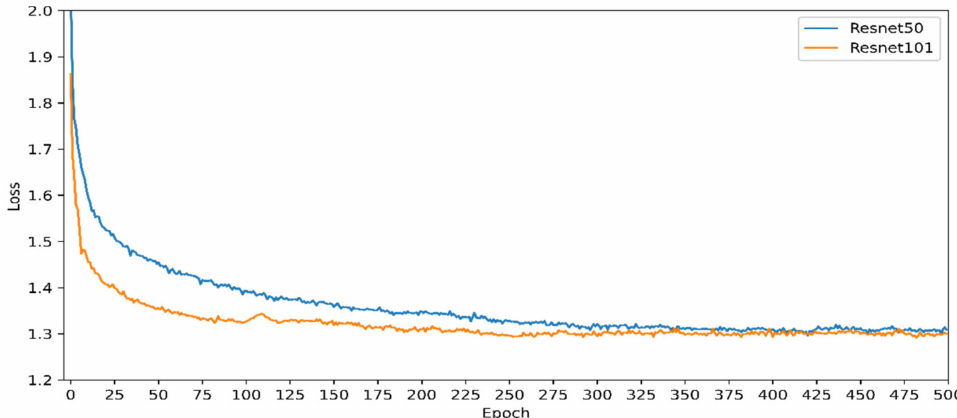
Figure 8. The comparison of ResNet-50 and ResNet-101 backbone.